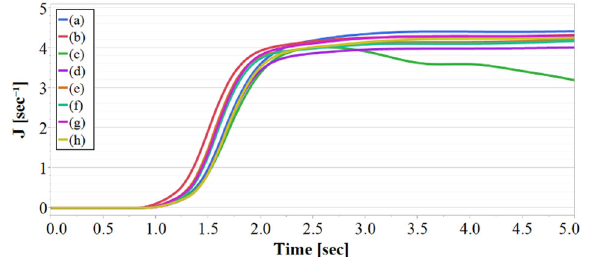
Fig. 7 Probability current through the JJ interface as a function of time. The calculations end after reaching the halting criteria. Models ( a – h ) in the legend coincide with the order presented in Fig. 3.